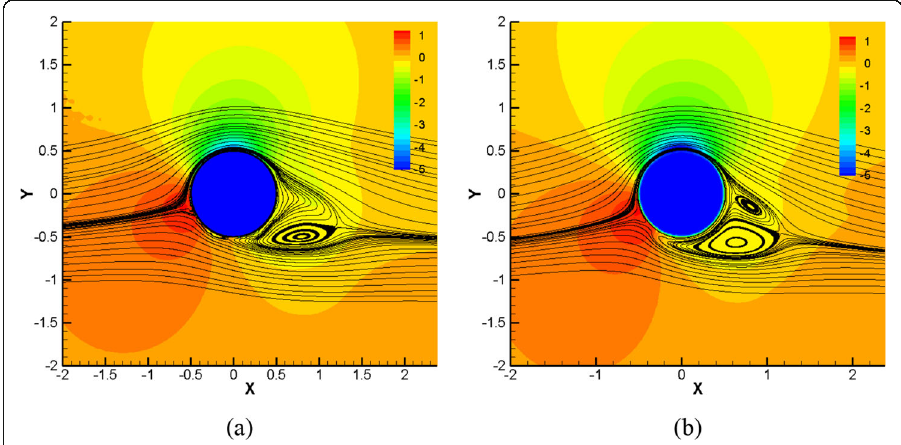
Fig. 3 Contours of the dimensionless pressure coefficient and streamlines for (a) AR = 10 and (b) AR =